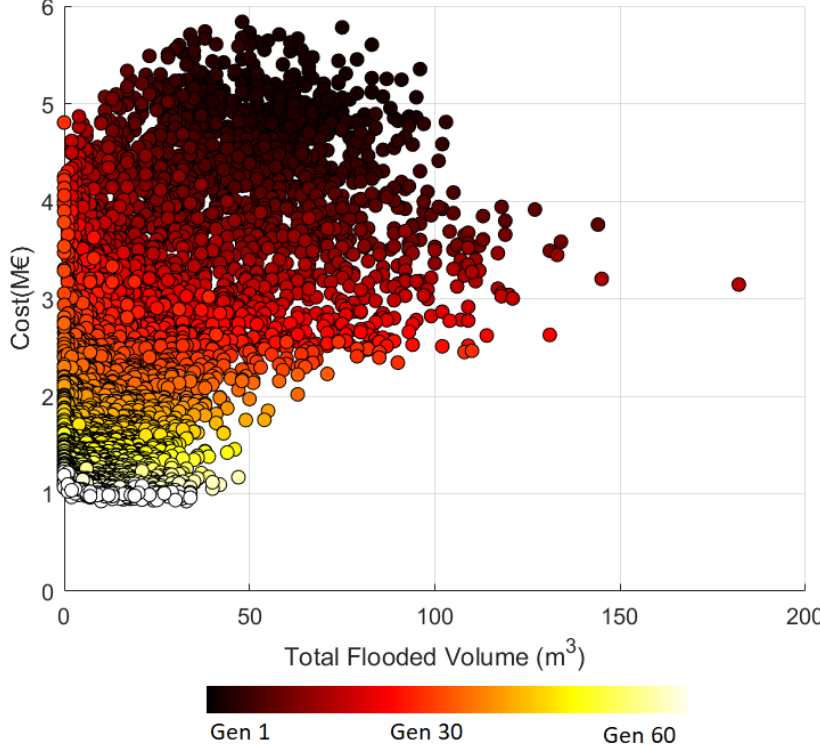
Figure 4. Pareto front with generations history for rainfall event T = 10 years and d = 30 min.